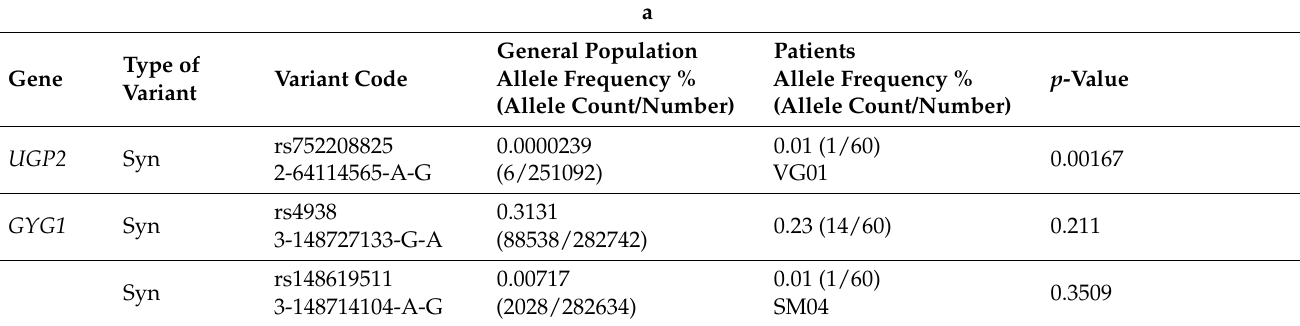
Table 2. Clinical data in sub groups of patients carrying di ff erent mutations on the second allele.